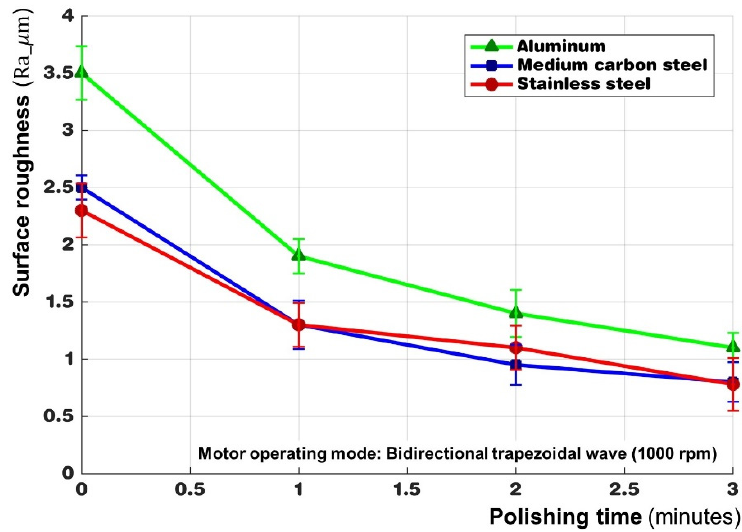
Figure 13. Comparison chart of average surface roughness and polishing time of three types of materials.